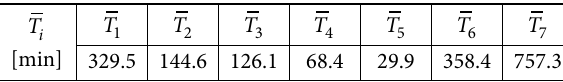
Table 8. Limit probabilities values P